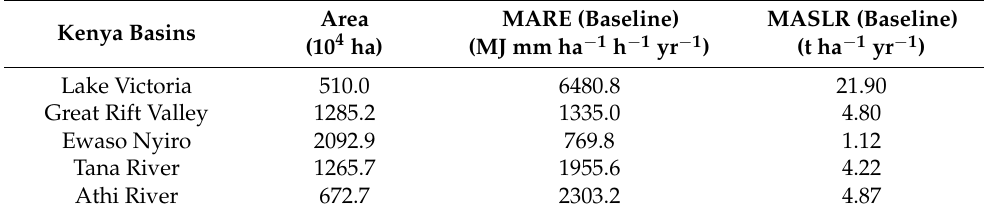
Table 9. Baseline soil erosion rates by river basins in Kenya.